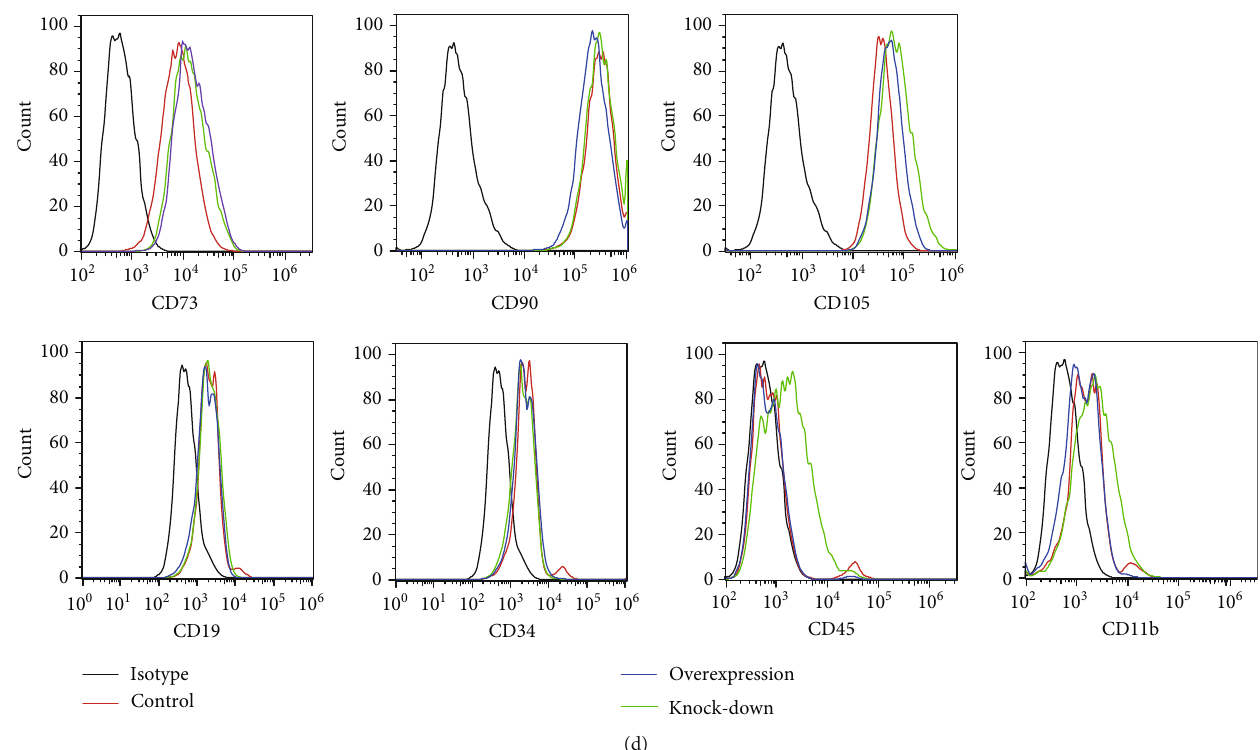
Figure 2: Phenotypes of di ff erent groups of transfected BM-MSCs. (a) The transfection e ffi ciency of the control group is shown. No less than 90% of BM-MSCs expressed green fl uorescent protein. Scale bar = 100 μ m . The e ffi ciency of overexpression or knock-down of PTPN21 was con fi rmed by RT-qPCR (b) and western blot analysis (c). A fl ag tag was attached to the C terminus of PTPN21 coding sequences in the overexpression plasmid, which acted as a reporter gene for transfection e ffi ciency identi fi cation. (d) Flow cytometry analysis of cell surface marker expression by transfected BM-MSCs. The black-lined histograms indicate isotypic controls, while the red-lined, blue-lined, and green-lined histograms represent the control, overexpression, and knock-down groups, respectively. All experiments were repeated at least three times. Data are presented as mean ± SD . ∗ p < 0 : 05